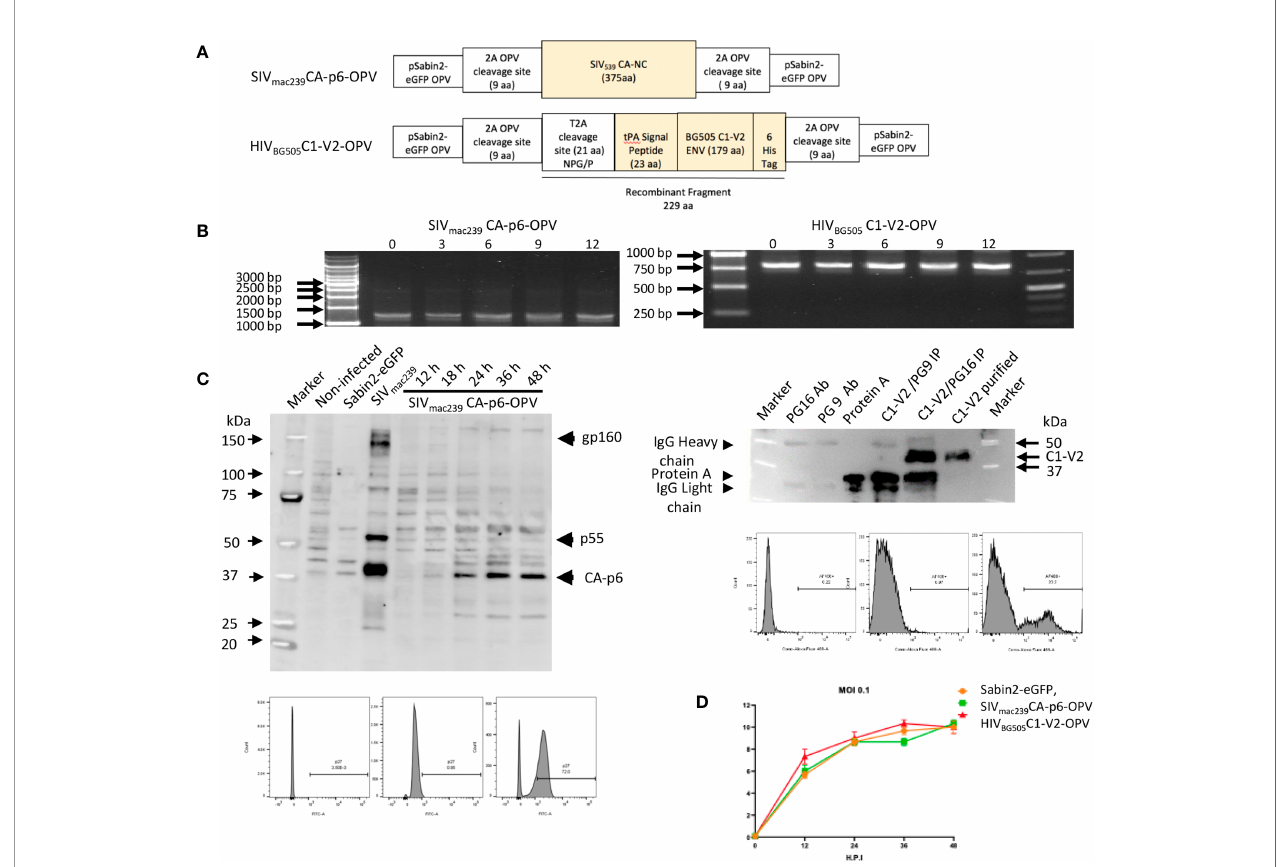
FIGURE 1 | (A) Schematic diagram of Recombinant OPVs: orange boxes illustrate the SHIV recombinant antigens that are ultimately produced by OPV. The SIV mac239 CA-p6 sequence was inserted between two 2A protease cleavage sites in pSabin2-eGFP, replacing gfp to generate SIV mac239 CA-p6-OPV. The corresponding protein becomes expressed intracellularly once the cleavage of the OPV polyprotein occurs. The HIV BG505 Env C1-V2 region was cloned linked to tPA signal peptide that permits its secretion to generate HIV BG505 C1-V2-OPV. The recombinant fragment amino acid sequence, starting and ending with polio protease cleavage sequences, with polio protease TTY / G and T2A NPG/P cleavage indicated by a bar, and with HIV Env sequence underlined, is the following: GLTTY / GFGHGGGGGGSRLEGSGEGRGSLLTCGDVEENPG / PMDAMKRGLCCVLLLCGAVFVSASAENLWVTVYYGVPVWKDAETTLFCASDAKAYETEKHNVWATHACVPT DPNPQEIHLENVTEEFNMWKNNMVEQMHTDIISLWDQSLKPCVKLTPLCVTLQCTNVTNNITDDMRGELKNCSFNMTTELRDKKQKVYSLFYRLDVVQINENQGNRSNN SNKEYRLINCNTSATQACPKVSFHHHHHHVDGLTTY/GFGH. (B) Stability of passaged recombinant OPVs: RT-PCR to detect recombinant OPV expression in RNA of infected cells after virus passage. Selective passages from 0 to 12 are reported. (C) Left top panel: Western blot of cell lysates from 293T cells: non-infected (lane 2), infected with Sabin2-eGFP (lane 3), transfected with SIV mac239 DNA (lane 4), infected with SIV mac239 CA-p6-OPV (lanes 5-9, harvested at 12 to 48 hrs after infection). A SHIV-infected monkey serum was used as primary antibody. Left bottom panels: fl ow cytometric analysis of 293T infected cells stained with an anti-SIV p27 antibody (unstained, DAPI stained, DAPI+anti-p27 panels). Right top panel: Detection of the HIV BG505 C1-V2 fragment by Western blot, probed with anti-HIS mAb: mAb PG16 (lane 2); mAb PG9 (lane 3), Protein A (lane 4), HIV BG505 C1-V2 fragment, puri fi ed from tissue culture supernatant after HIV BG505 C1-V2-OPV infection and immunoprecipitated with NAb PG9 (lane 5) or with NAb PG16. (lane 6), puri fi ed HIV BG505 C1-V2 (lane 7). Right bottom panels: fl ow cytometric analysis of 293T infected cells stained with an anti-HIS mAb (unstained, DAPI alone staining, DAPI+anti-HIS staining panels). (D) Growth curve of recombinant OPVs in 293T cells. After 293T cell infection at 0.1 MOI with Sabin2-eGFP, SIV mac239 CA-p6-OPV and HIV BG505 C1-V2-OPV, supernatants were harvested at time points indicated on the X axis and the corresponding titer, obtained by TCID 50 evaluation, is reported on the Y